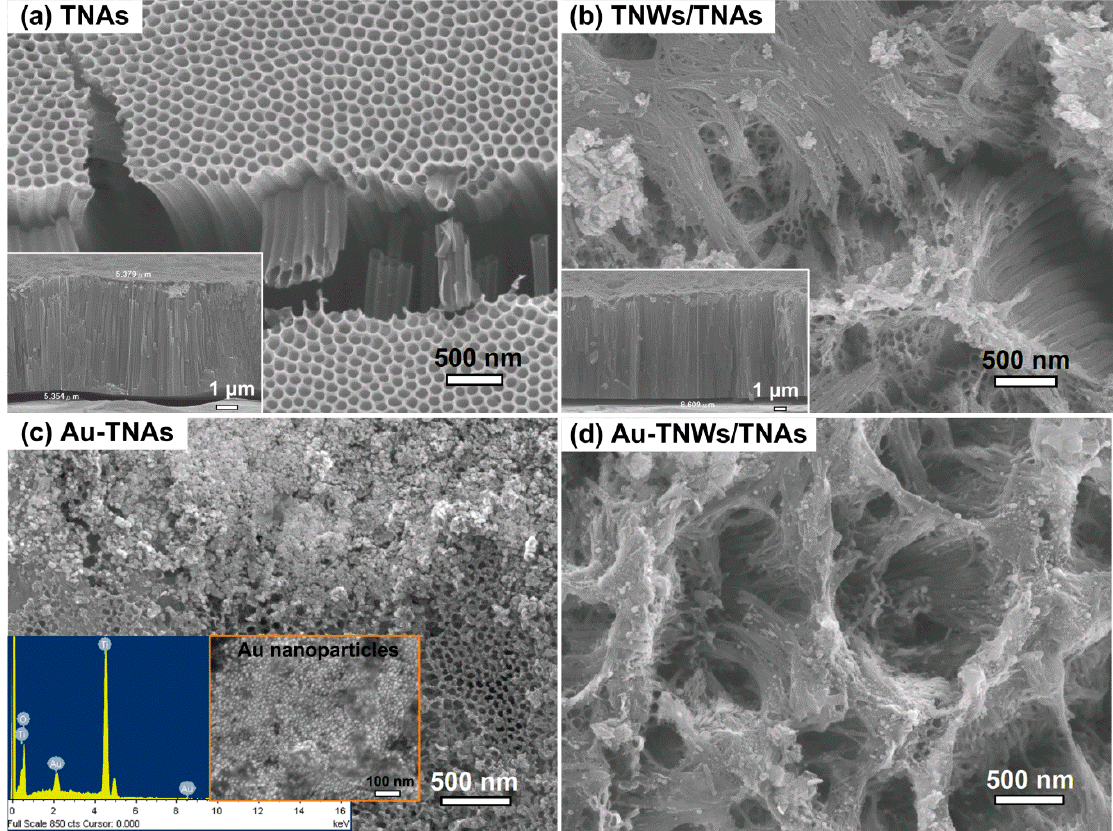
Figure 2. SEM images of ( a ) TNAs, ( b ) TNWs/TNAs, ( c ) Au-TNAs, and ( d ) Au-TNWs/TNAs. The insets in ( c ) show a typical EDS spectrum for Au-TNAs and Au-TNWs/TNAs, and the morphology of as-synthesized Au nanoparticles. Materials 2019 , 12 , x FOR PEER REVIEW